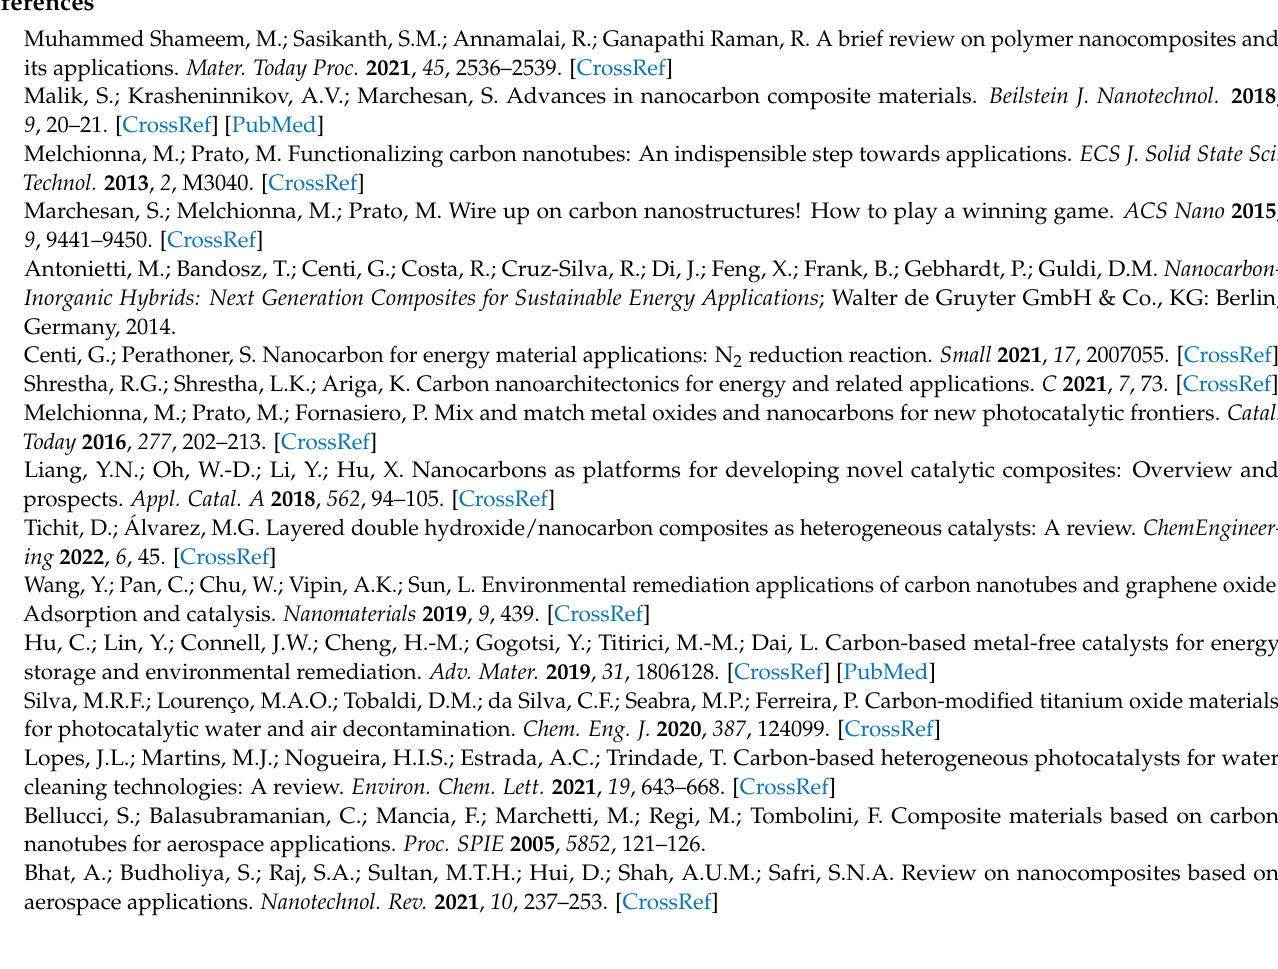
(Figure S18), photographs of the Lff-PEG-CNO dispersion prior to peptide gelation (Figure S19), TEM images of the covalent gel (Figures S20–S21), photographs of the Lff-PEG-CNOs dispersion in the gel-precursor solution with Lff (Figure S22), oxi-CNOs release data (Figure